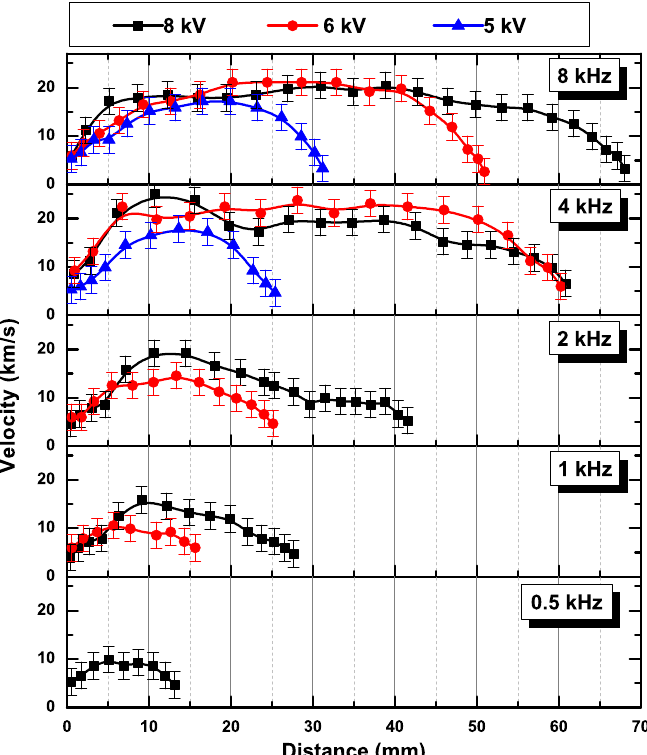
Figure 6. Plasma jet length scaling with the frequency and amplitude of the HV pulses (positive polarity, 50 µ s duration and 3 L/min helium flow rate); the origin of O x axis is considered the top of the dielectric tube. Error bars indicate the standard deviation of three independent